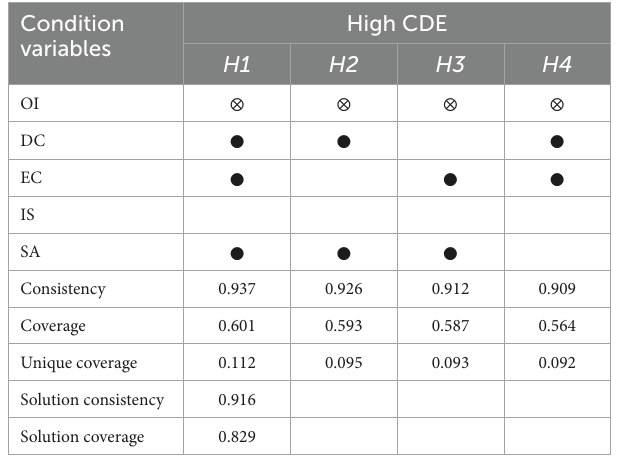
TABLE 8 The configuration conditions for the formation of non-high